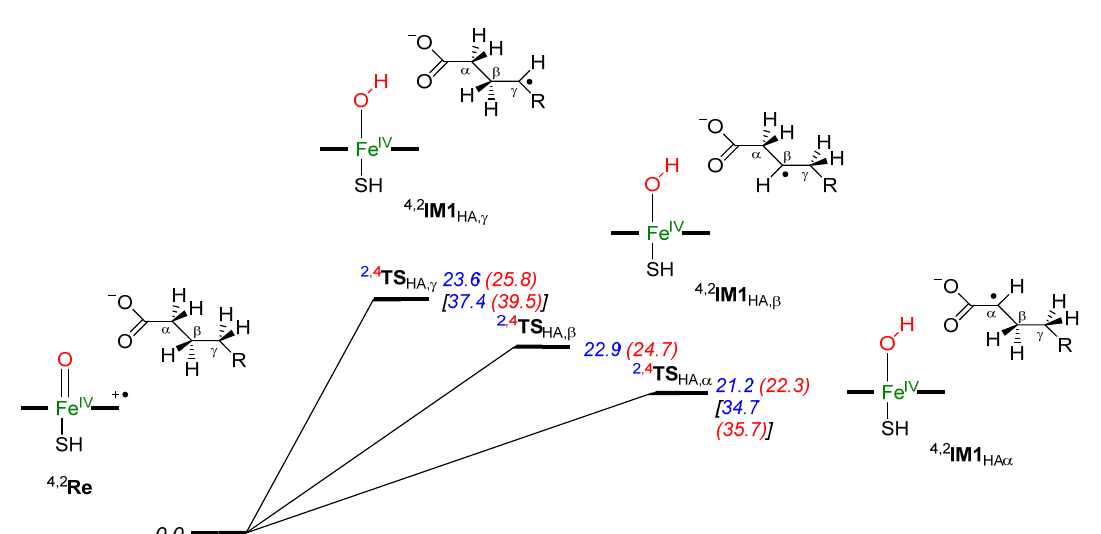
Figure 3. Potential energy landscape calculated at UB3LYP/BS1+ZPE//UB3LYP/BS2 for various hydrogen atom abstraction pathways by Cpd I of P450 OleT JE . Energies contain zero-point corrections and are given in kcal mol ‒ 1 . The values in square brackets are free energies with solvent, zero-point, entropic and thermal corrections at 298K included.